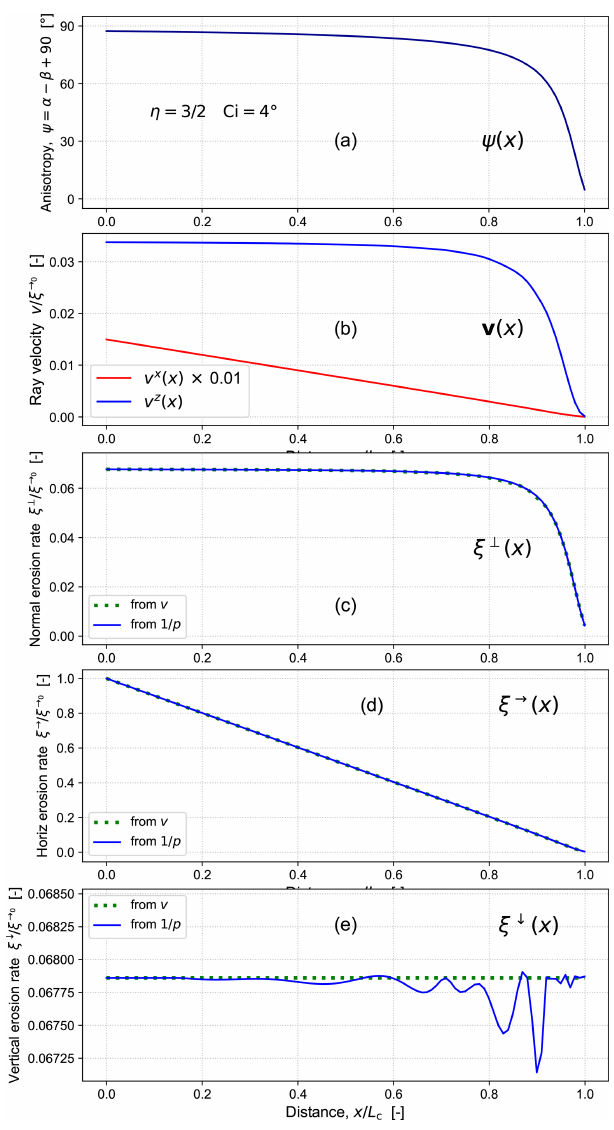
Figure 16. Ray and front behaviour along a time-invariant pro- and Ci = 4 ◦ : (a) anisotropy ψ , i.e. ray-front angular file for η = 1 2 disparity ( α − β + 90 ◦ ), (b) horizontal (red) and vertical (blue) ray speeds v x and v z , (c) surface-normal erosion rate ξ ⊥ , (d) horizontal erosion rate ξ → , and (e) vertical erosion rate ξ ↓ . All rates are nor- malized by the reference horizontal erosion rate ξ → 0 , i.e. the rate imposed at the boundary x =